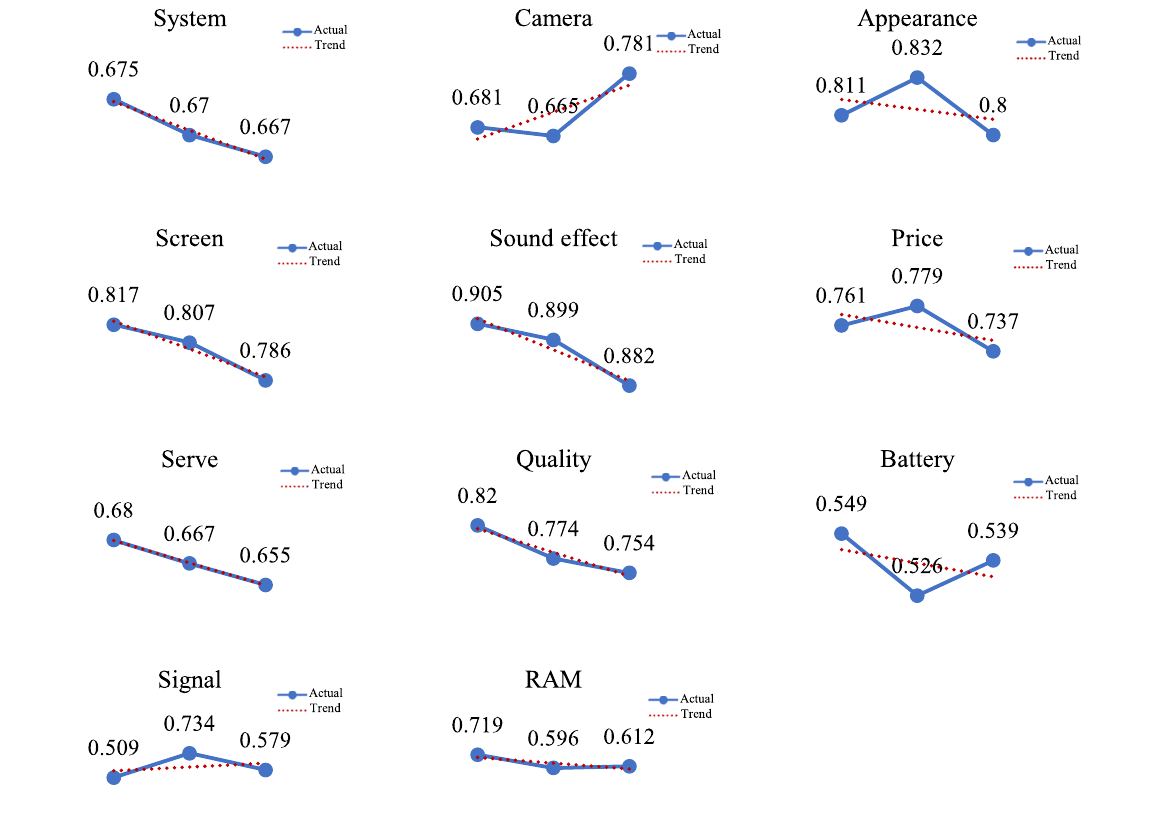
Figure 11 Dynamic trend of product attributes of multi-generation